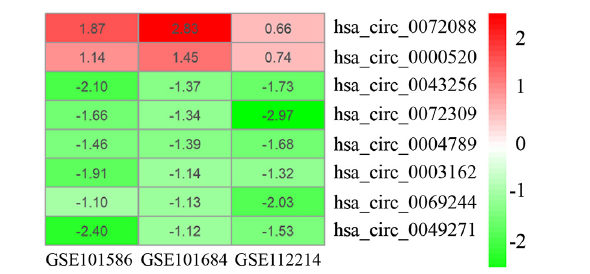
FIGURE 2 | Heatmap of eight DEcircRNAs in three microarray